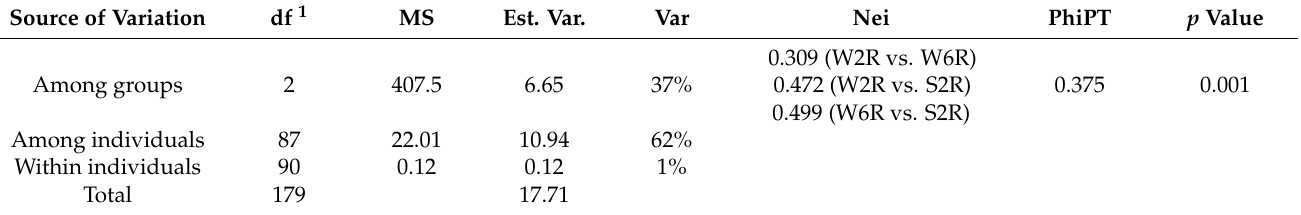
Table 3. Analysis of molecular variance among and within barley groups.